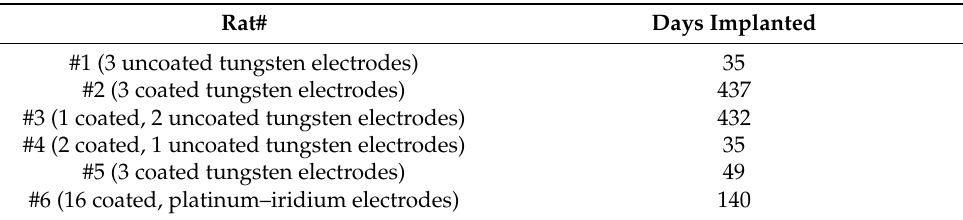
Table 1. Experimental details for cohort of rats in this study ( n =